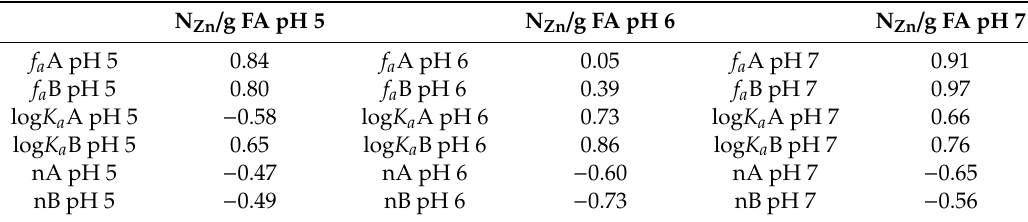
Table 4. Coe ffi cients of Person’s correlation calculated between fraction of accessible fluorophores, f a , stability constants, log K a , number of binding sites, n , (determined from fluorescence spectroscopy) and Zn(II) binding e ffi ciency (determined from proton releasing studies) at pH 5, 6 and 7. Bold digits highlight statistically significant relationships for α =